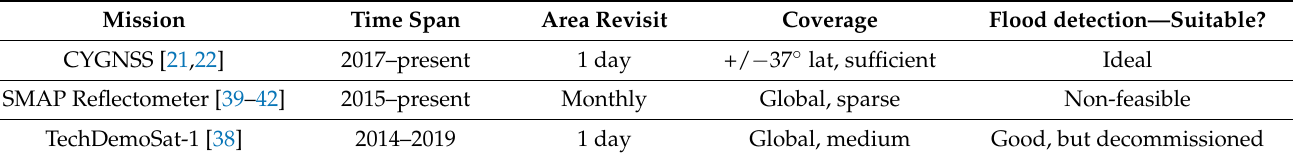
Table 2. Bistatic Radar